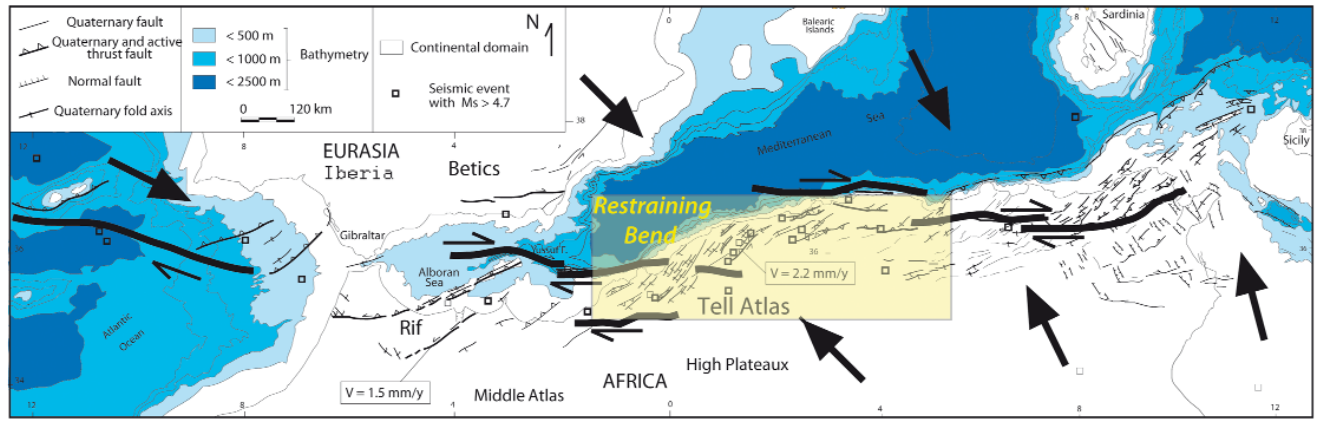
Figure 5. Map showing the plate boundary as a narrow E-W-striking, right-lateral deforming zone that limits the left-lateral, NE-SW-trending faults (see also block rotations in Figure 4). Large arrows indicate convergence plate directions according to the GPS vectors in northern Iberia, southern Morocco and southern Sicily–Lampedusa [Anzidei et al. 2001, Fernandes et al. 2007, Serpelloni et al. 2010, Vernant et al. 2010]. The oblique convergence implies an eastwards increase in the contractional-to-trancurrence ratio (see also Tables 2 and 3). The oblique convergence and geometry of the deforming zone at the plate boundary indicates an area (shaded) of restraining bend with significant transpressive deformation, which corresponds to the zone of the greatest earthquake activity in North Africa. V is the local shortening